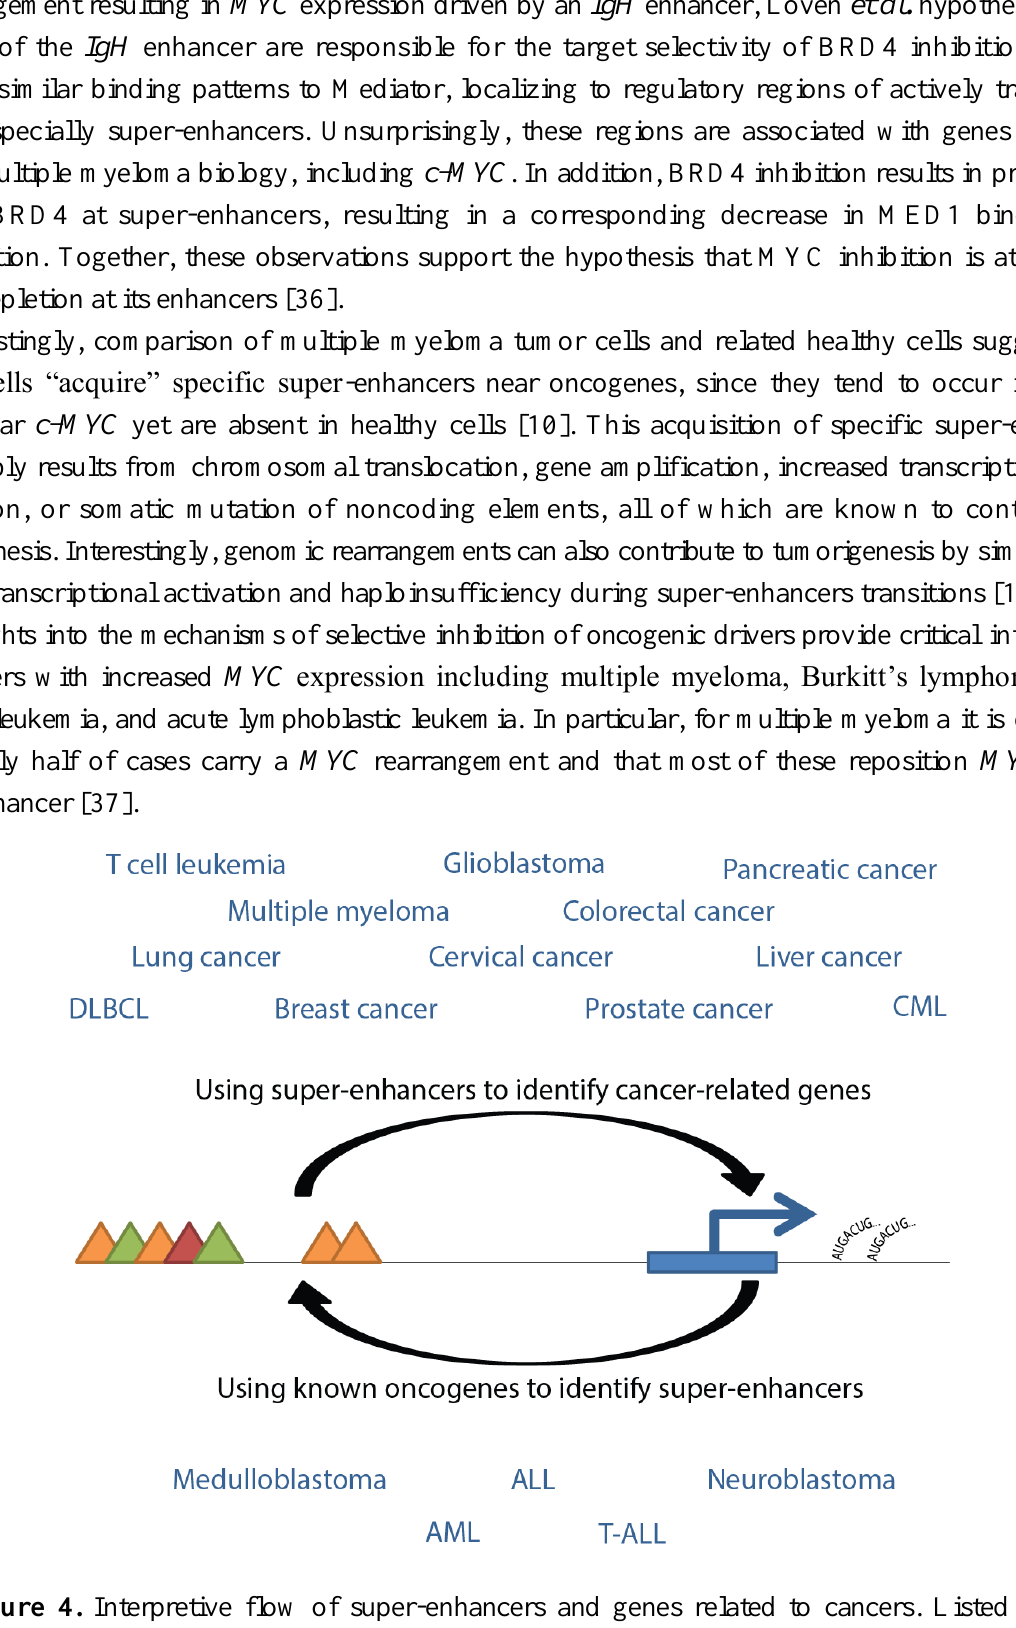
Figure 4. Interpretive flow of super-enhancers and genes related to cancers. Listed are cancer types for which gene-associated super-enhancers have been identified, either using super-enhancer sequences or oncogenes as the reference point. Triangles represent transcription factors, post-translational modifications, or Mediator complex, as in Figure